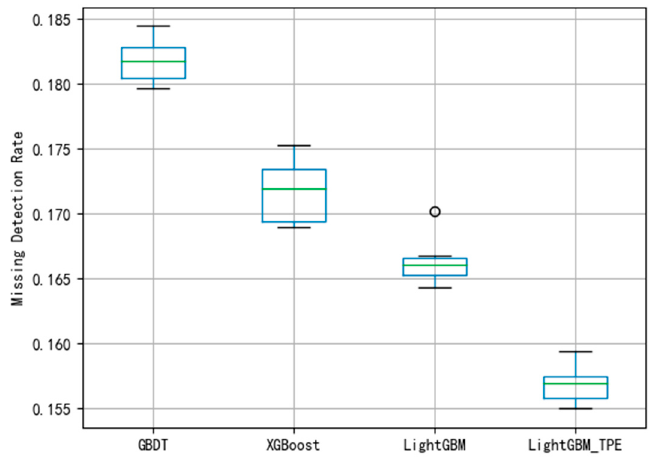
Figure 11. Missing detection rates of four algorithms of wind turbines gearboxes on dataset 3.